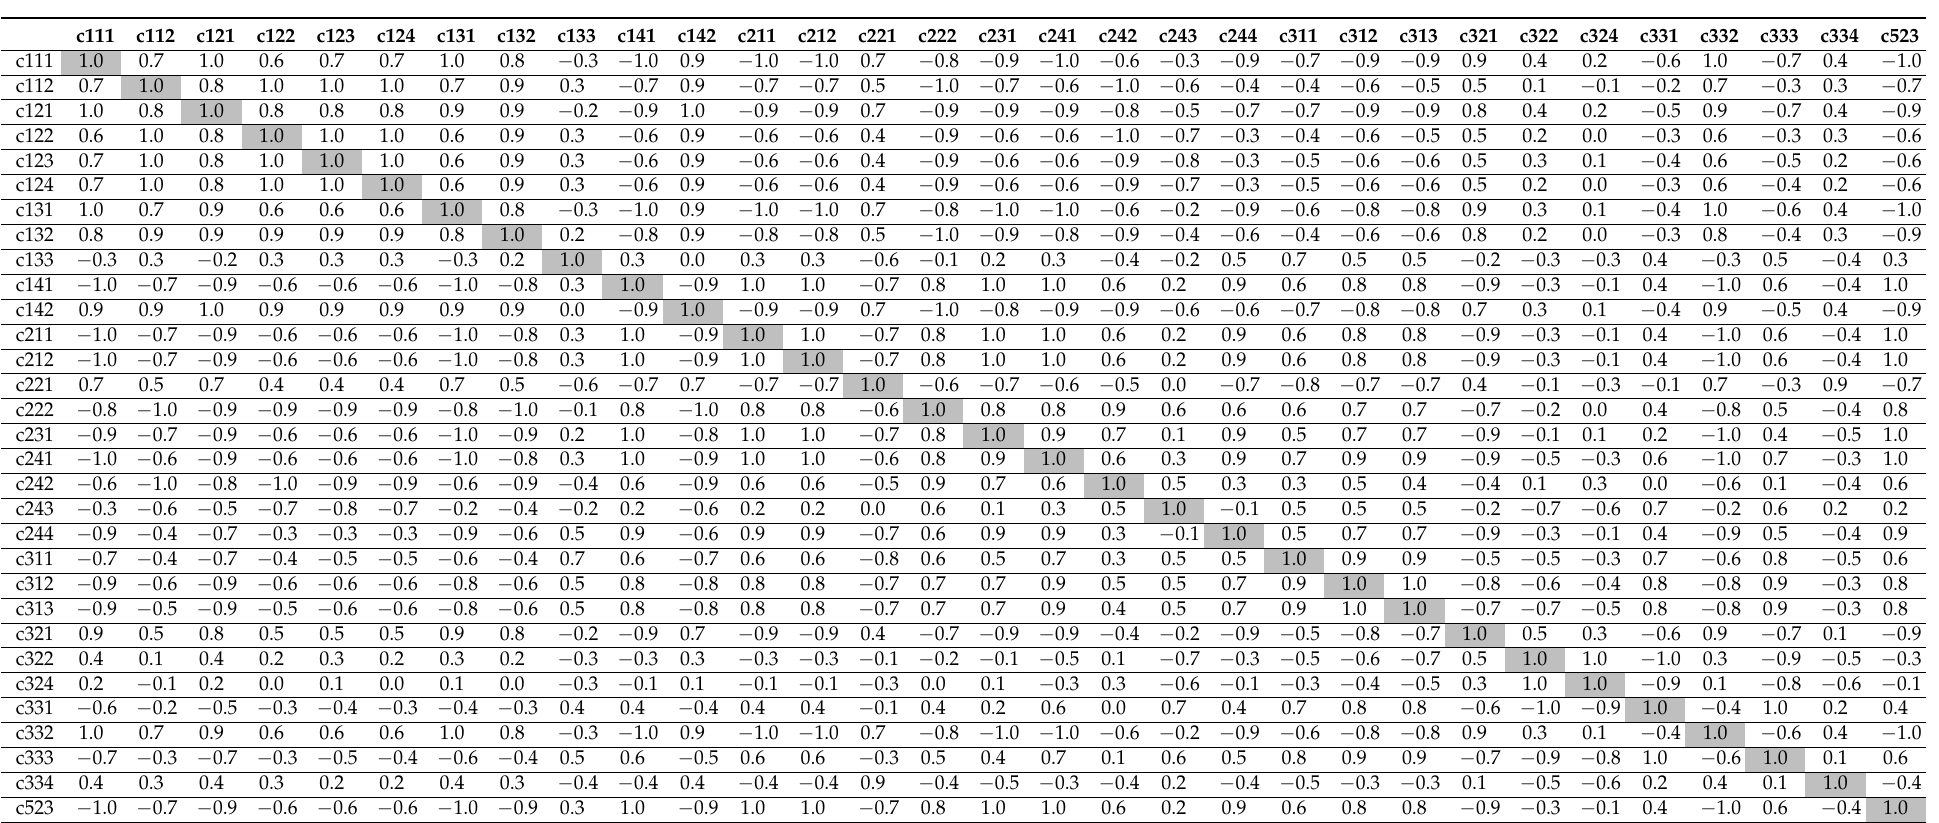
Table A2. Spearman’s rank correlation coefficient values in the Madeira archipelago for land-uses at level 3 according to the CLC nomenclature between 1990 and